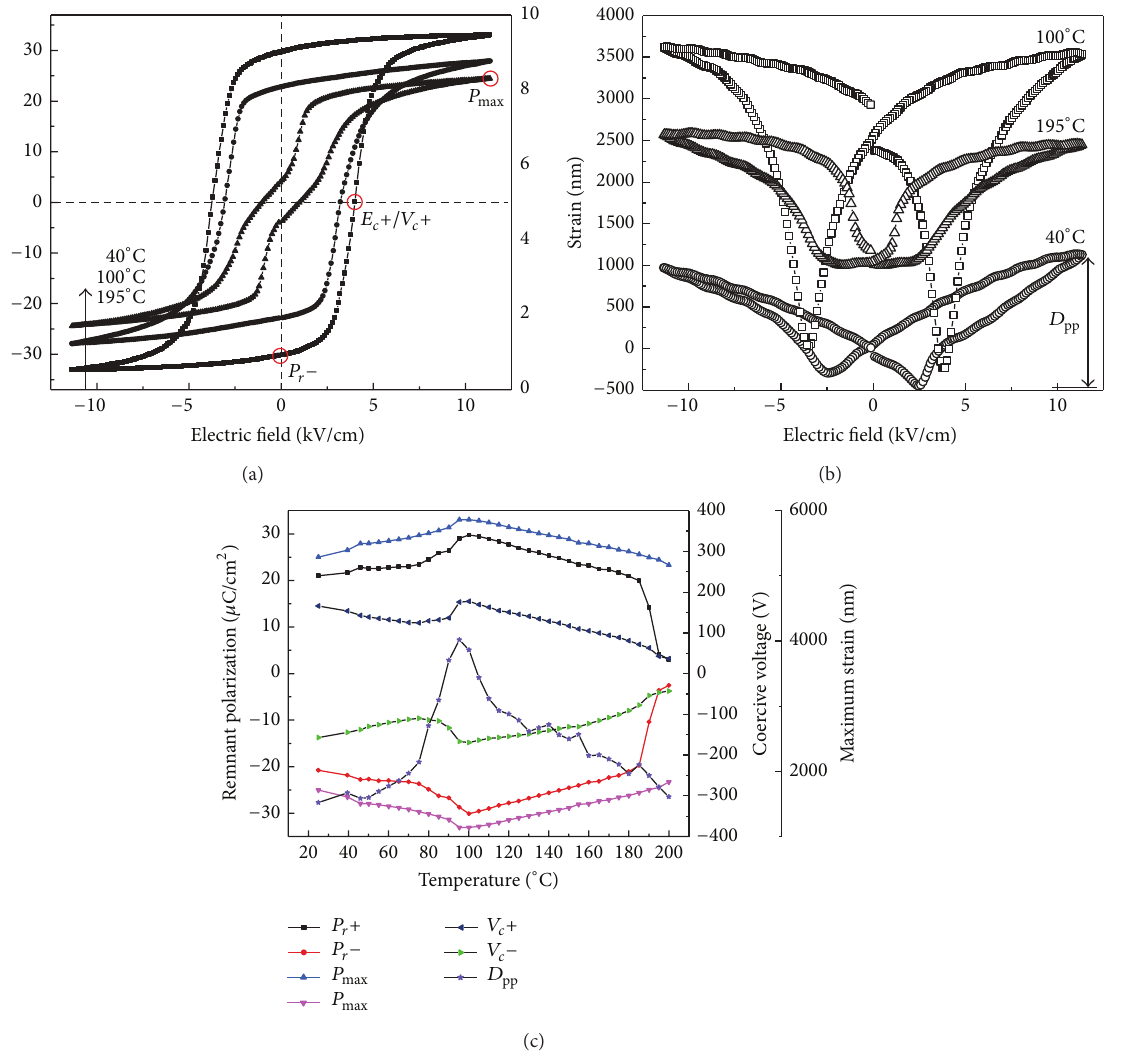
Figure 2: (a) P-E and (b) S-E hysteresis loops of 0.29PIN-0.44PMN-0.27PT single crystals, at three selected temperatures and (c) temperature dependence of the parameters deduced from those loops. Note that for clarity the S-E loops in (b) are vertically